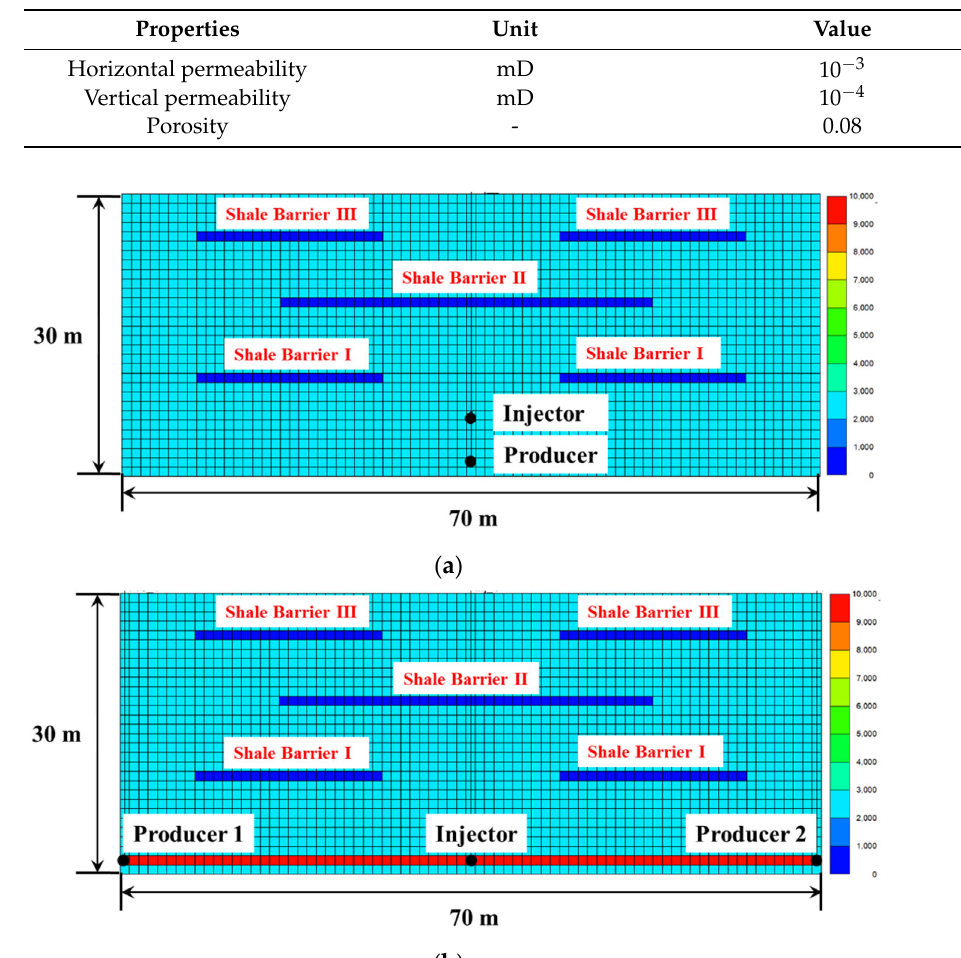
Table 2. Basic properties of bitumen.